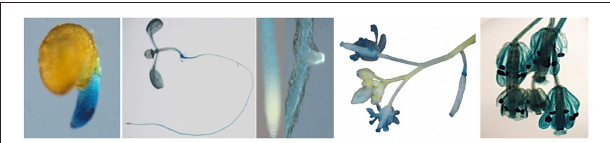
FIGURE 3 | Activity of CaCIPK25 gene promoter in different tissues in transgenic Arabidopsis . CaCIPK25 gene promoter up to the translation start codon was fused to GUS gene and introduced in Arabidopsis to study promoter activity in different tissues. Representative samples were shown after histochemical GUS staining. Tissues shown from left were radicle, whole seedling, root apex, lateral root initial flower buds and flowers, flower at higher magnification.